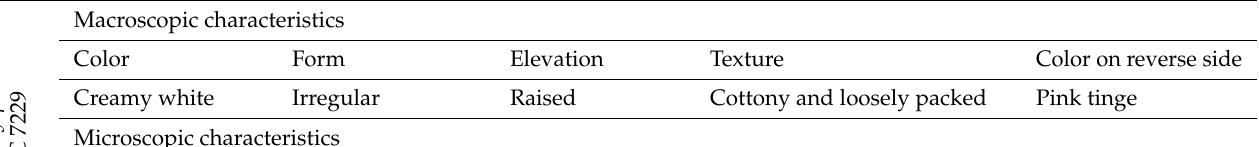
Table 1. Macro-microscopic observation of Fusarium oxysporum MTCC 7229 1 .